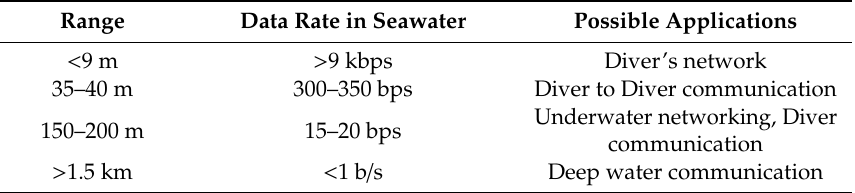
Figure 6. Multipath electromagnetic propagation in seawater. Table 5. Different data rates and applications of electromagnetic waves in water [5].